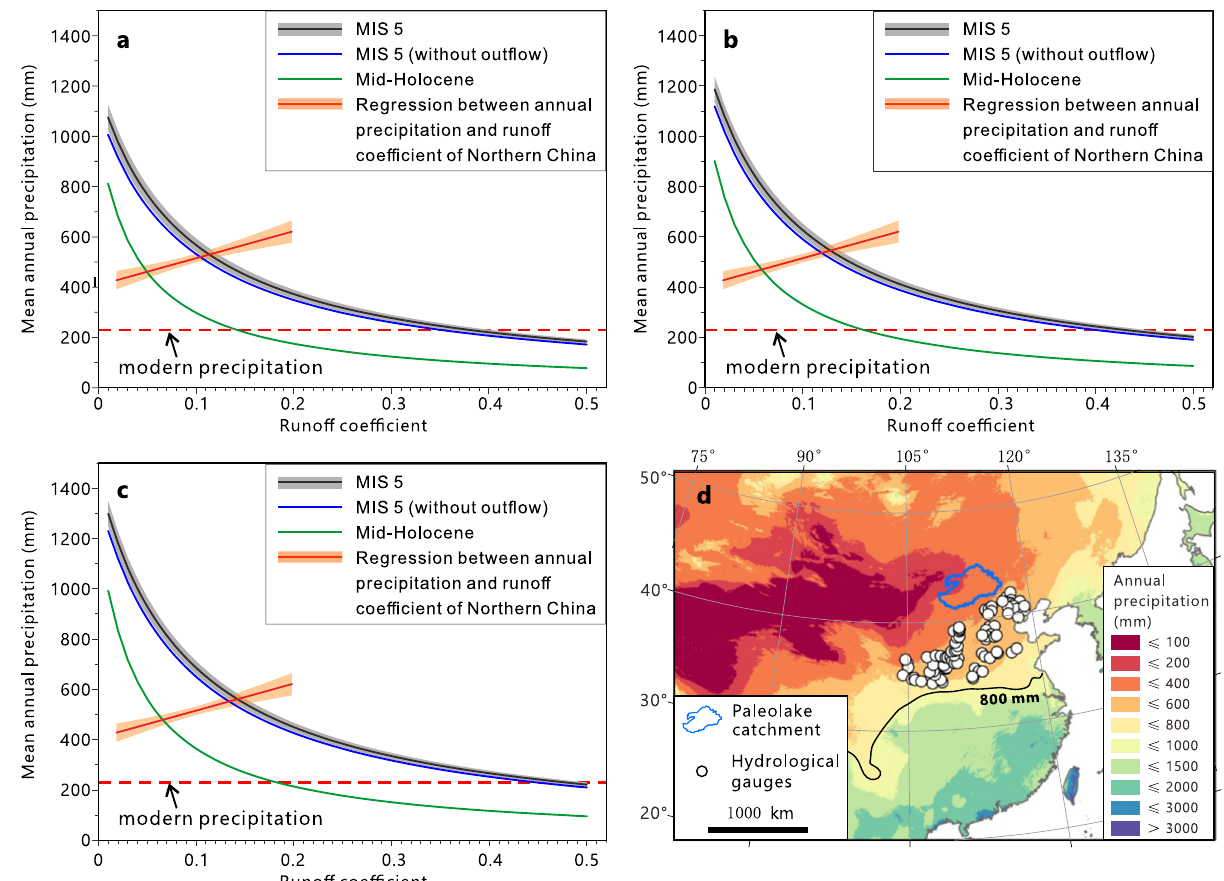
Fig. 6 | Precipitation reconstructions. a – c Annual precipitation of different per- iods estimated by a water balance model with different lake evaporation rates: a 900mm/yr, b 1000mm/yr, c 1100mm/yr. The black and blue lines represent conditions when the NB reached its highest stand with and without out fl ow from the lake system through the meander (Fig. 2h), respectively. The gray shaded area shows the uncertainties caused by meander out fl ow volume estimation (95% con- fi dence level) (Supplementary Fig. 9; Supplementary Table 5). The mid-Holocene